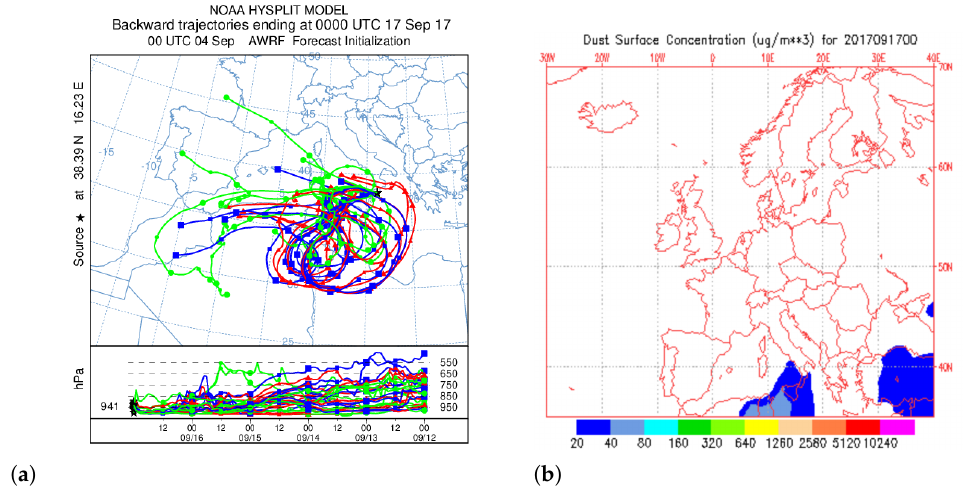
Figure 5. ( a ) 120 h WRF-HYSPLIT back-trajectories ending at the Mammola station and ( b ) dust Surface Concentration modelled by NAAPS. Both maps refer to 17th of September,